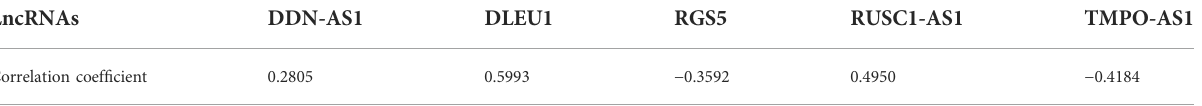
TABLE 1 The coef fi cients (coef) of the fi ve necrosis-related lncRNAs with prognostic signi fi cance. LncRNAs